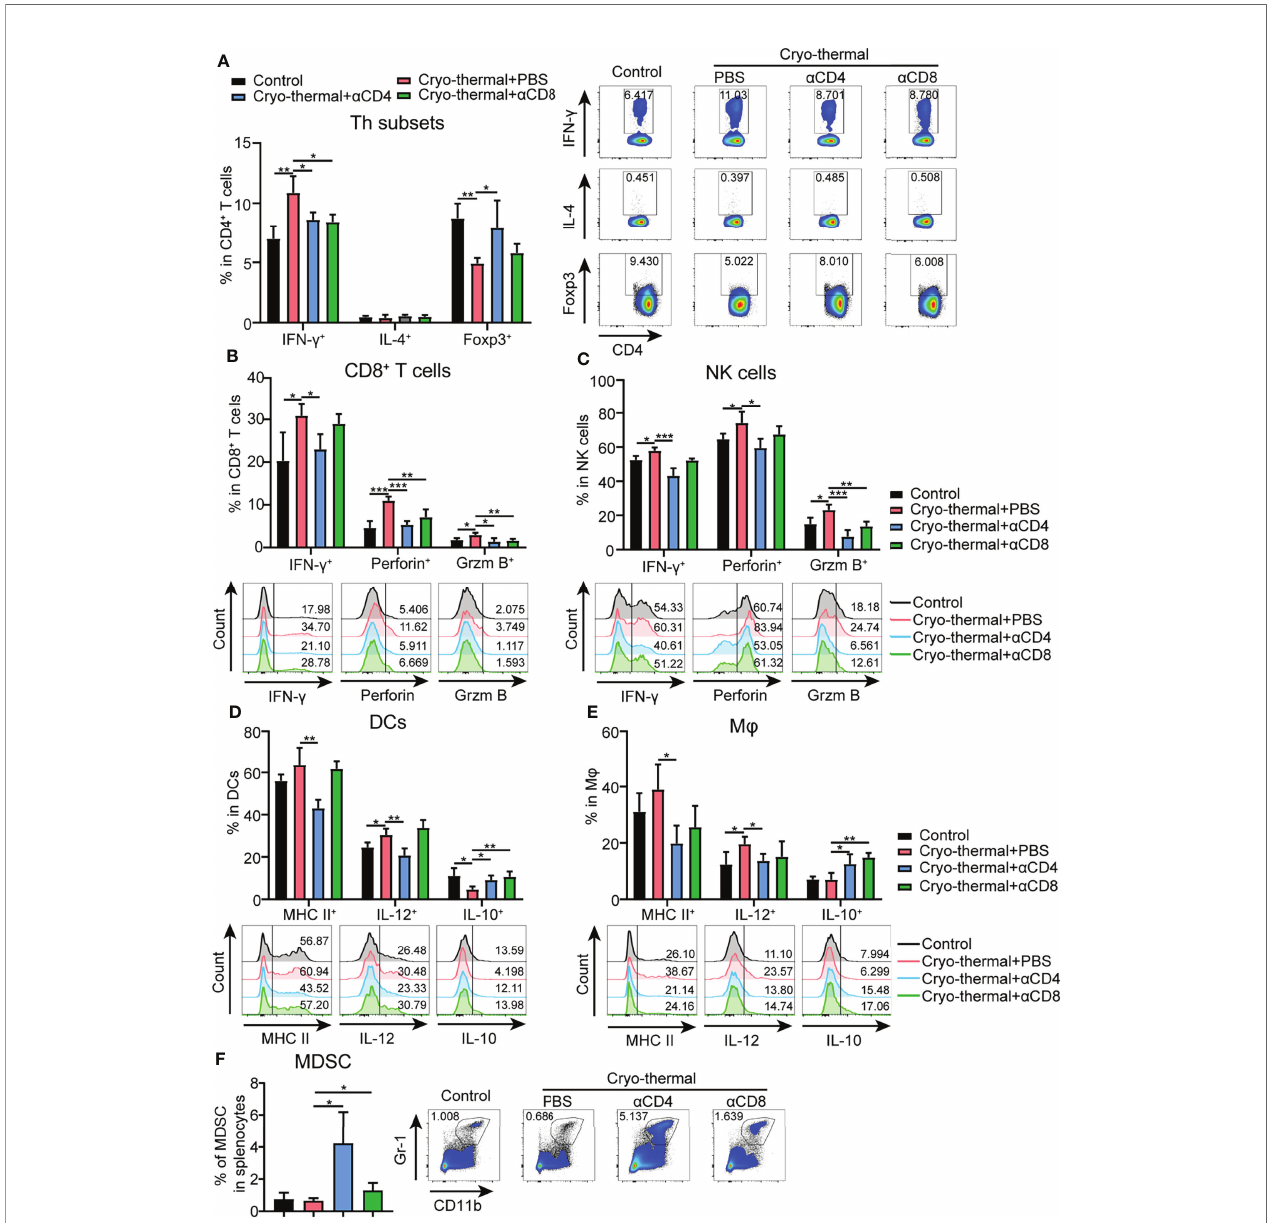
FIGURE 2 | Phenotype of immune cells in tumor rechallenge model depleted of T cells after cryo-thermal therapy in vivo . Eighteen days after tumor rechallenge, the phenotype of (A) CD4 + T cells; (B) CD8 + T cells; (C) NK cells; (D) DCs; and (E) M j s; and (F) frequency of MDSCs in the spleen. All data were shown as mean±SD. n=4 for each group. *P < 0.05, **P < 0.01, ***P < 0.001, ****P < 0.0001. Data for graphs were calculated by using two-sided Student ’ s